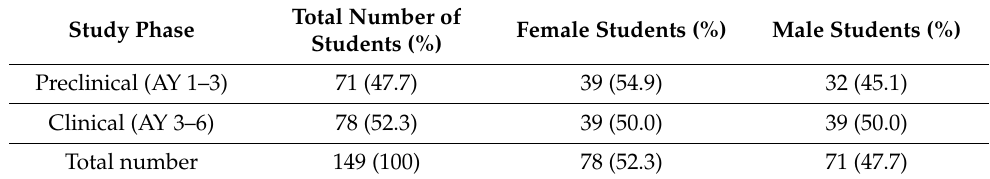
Table 3. Distribution of participating students by preclinical or clinical study phases/academic years